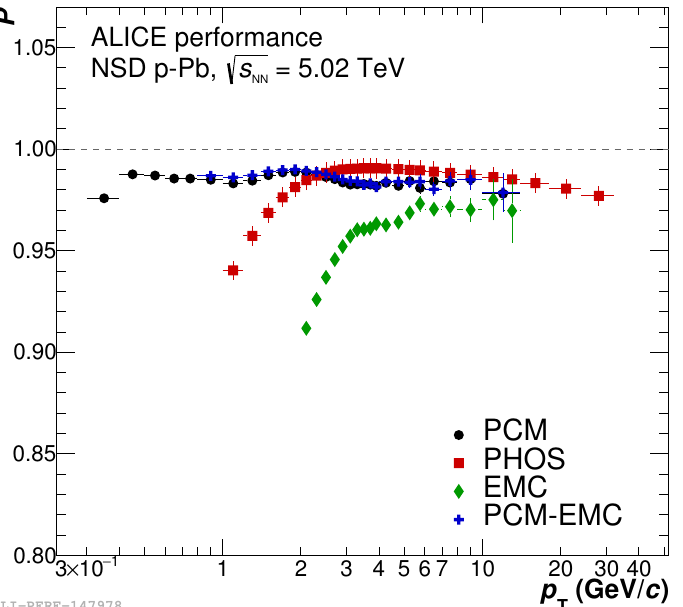
Figure 5. Purity of the inclusive photon sample in Non-Single-Diffractive (NSD) p–Pb collisions at √ s NN = 5 TeV for different reconstruction techniques